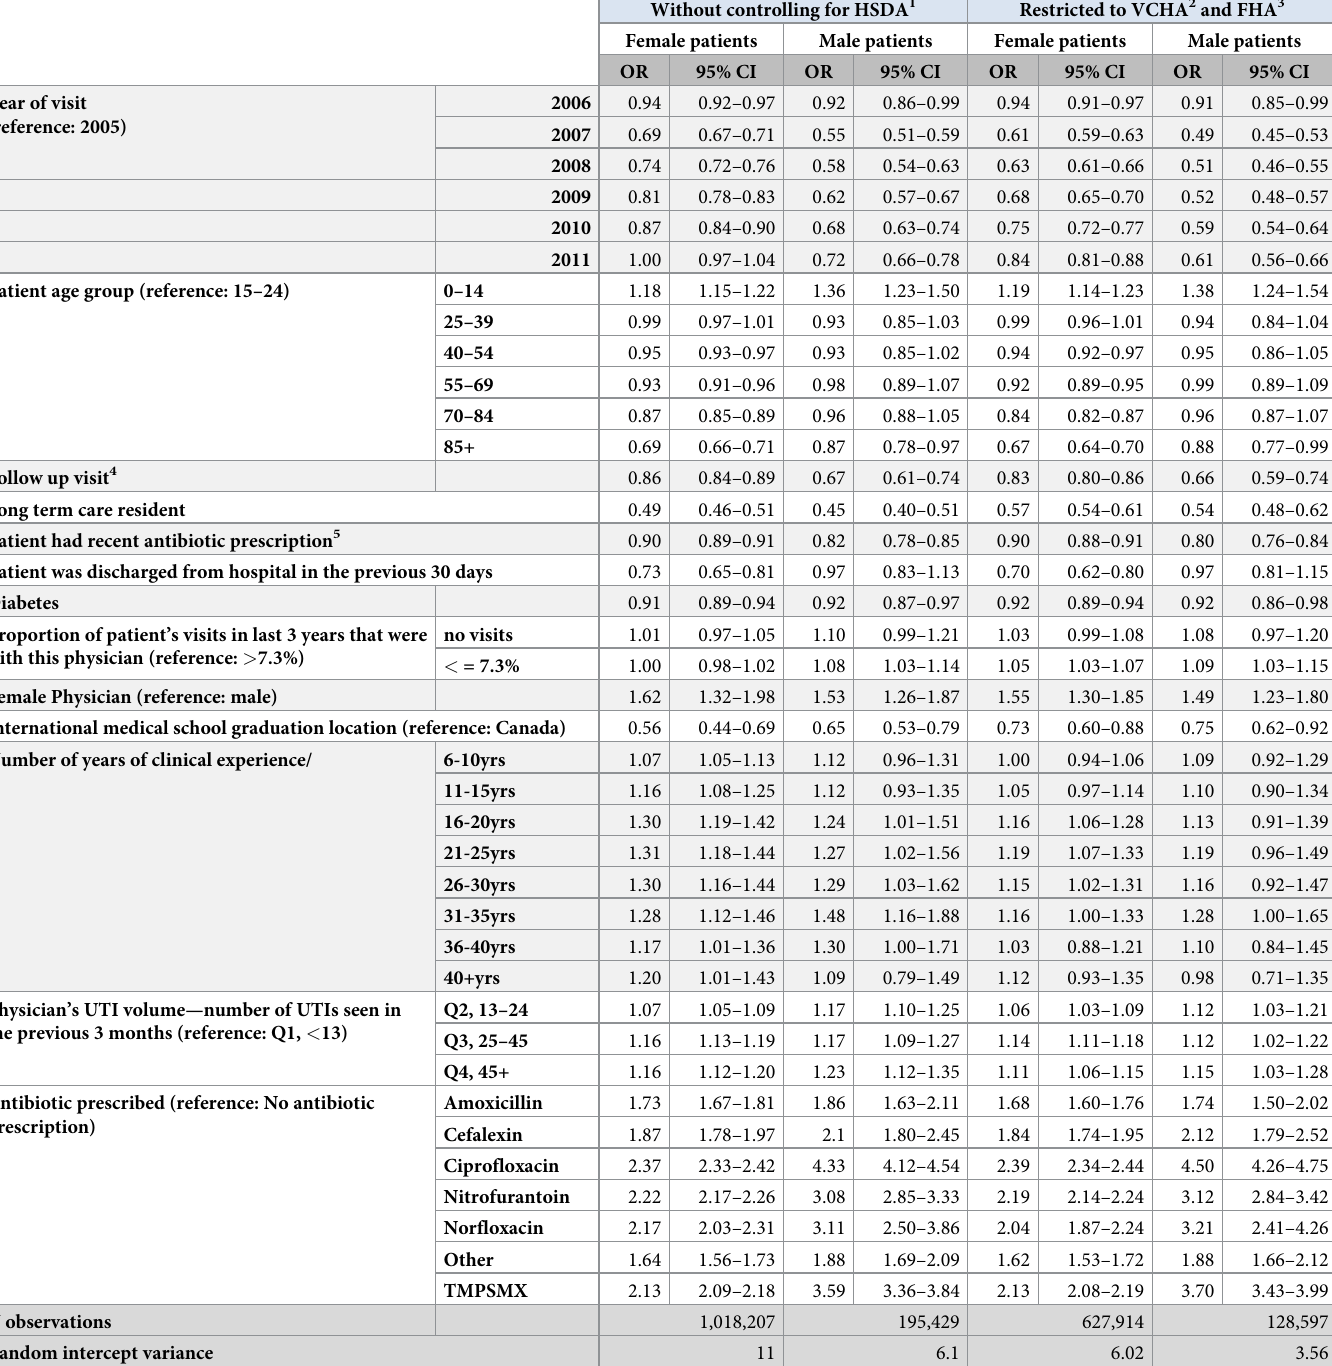
Table 3. LifeLabs coverage sensitivity analyses. Generalized linear mixed models for the odds of urine culture per cystitis visit. Full model results presented for model that did not control for region, and that was restricted to the broad regions with highest LifeLabs